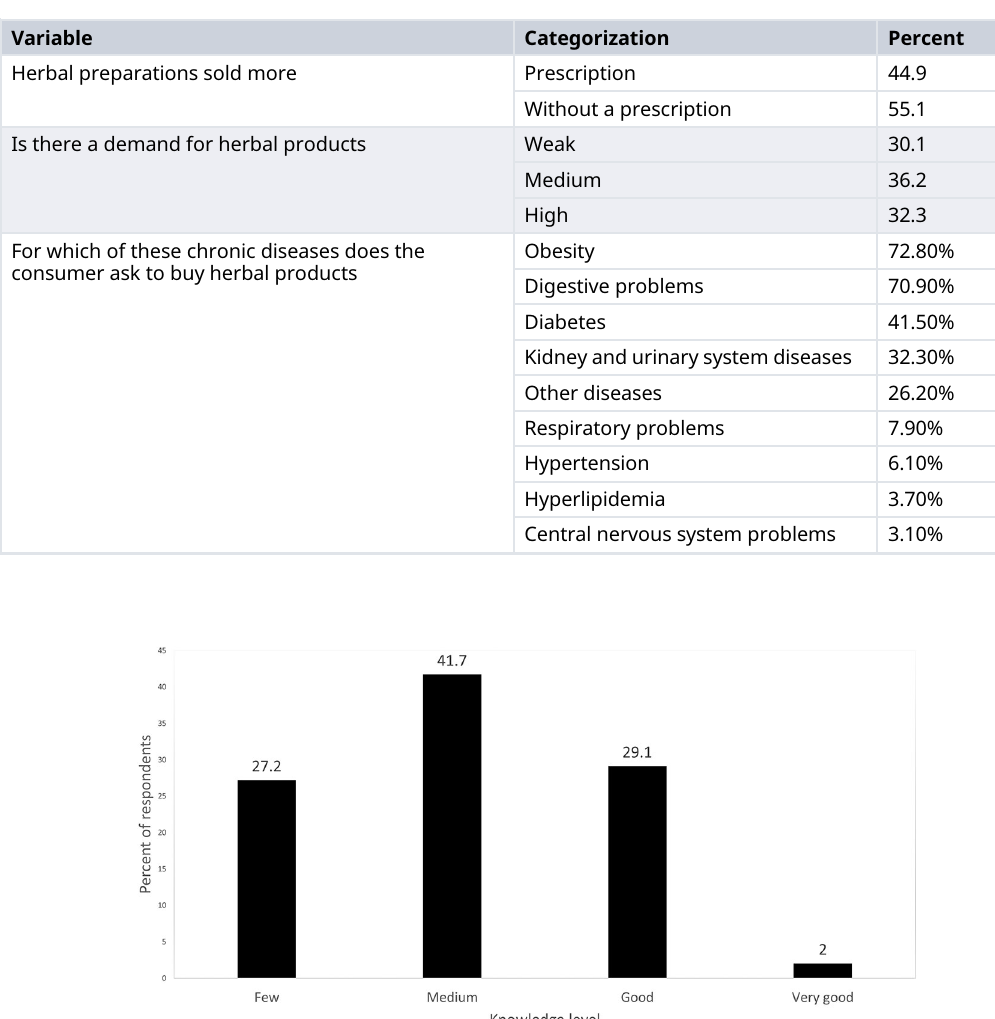
Table 2. Pharmacy practitioners ’ practice towards herbal remedies in community pharmacies.